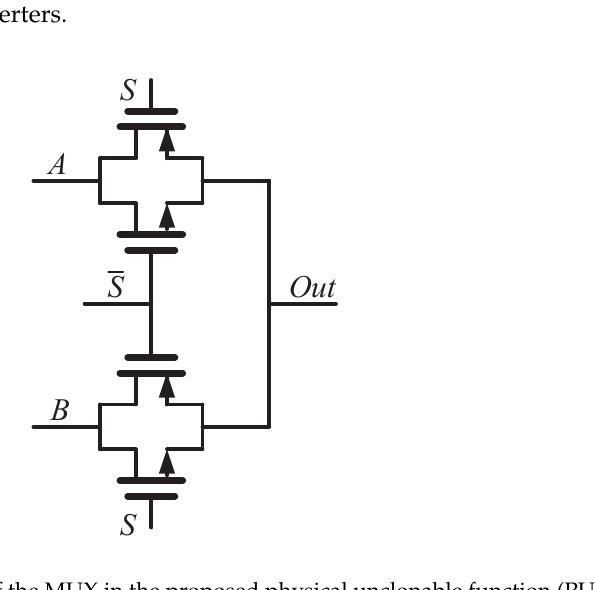
Figure 3. Schematic of the MUX in the proposed physical unclonable function (PUF). Each response bit of this PUF is produced by comparing two randomly selected ROs’